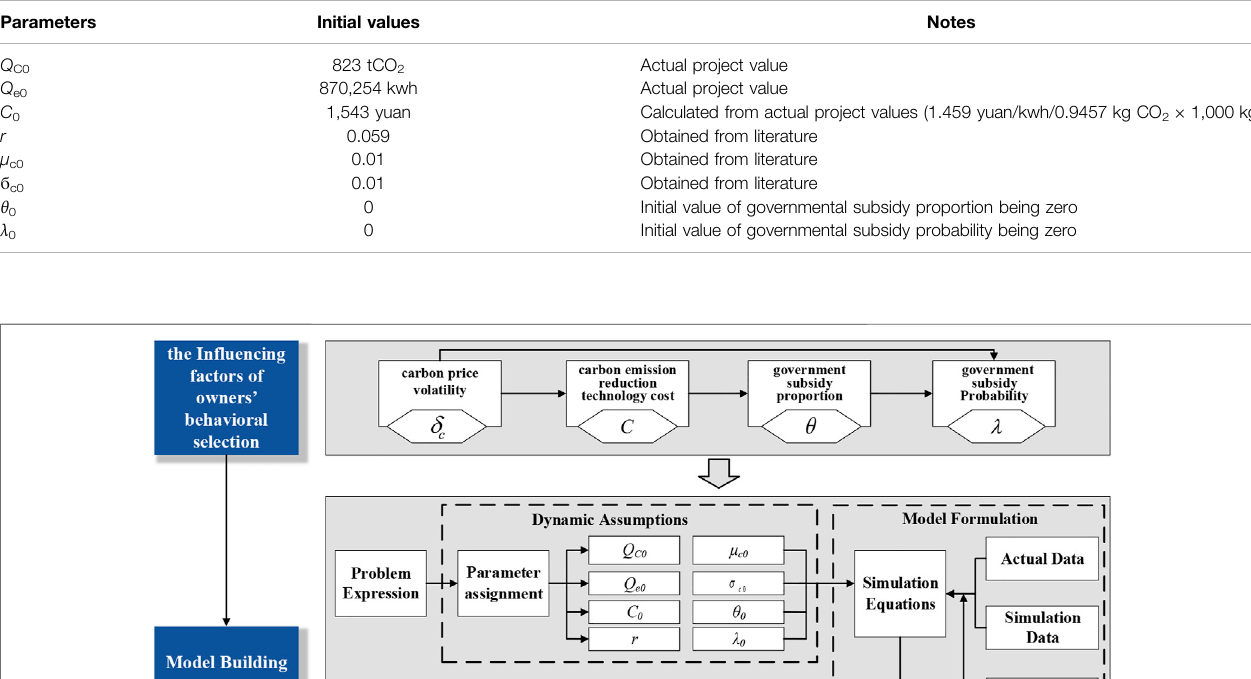
TABLE 2 | Values of parameters in the carbon-emission reduction investment model of public building owners.